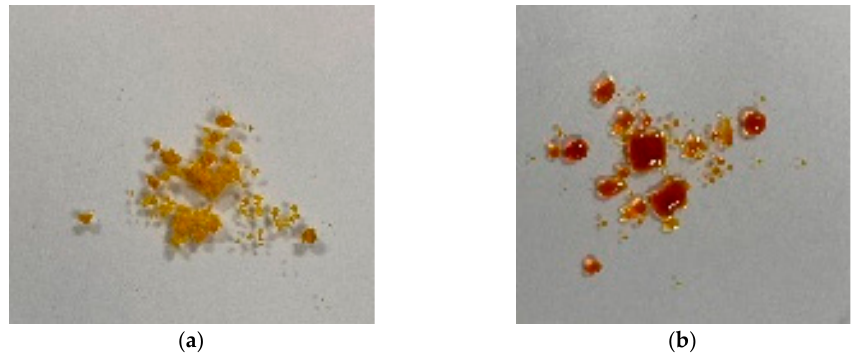
Figure 9 . FeCl 3 · 6 H 2 O crystals before ( a ) and after 30 min reductive Varigon low-pressure treatment ( b ). As can be seen in picture ( b ), the plasma caused a liquefaction of the crystalline starting material. Under a microscope, clear changes were observed in the salts CuCl 2 and FeSO 4 . After